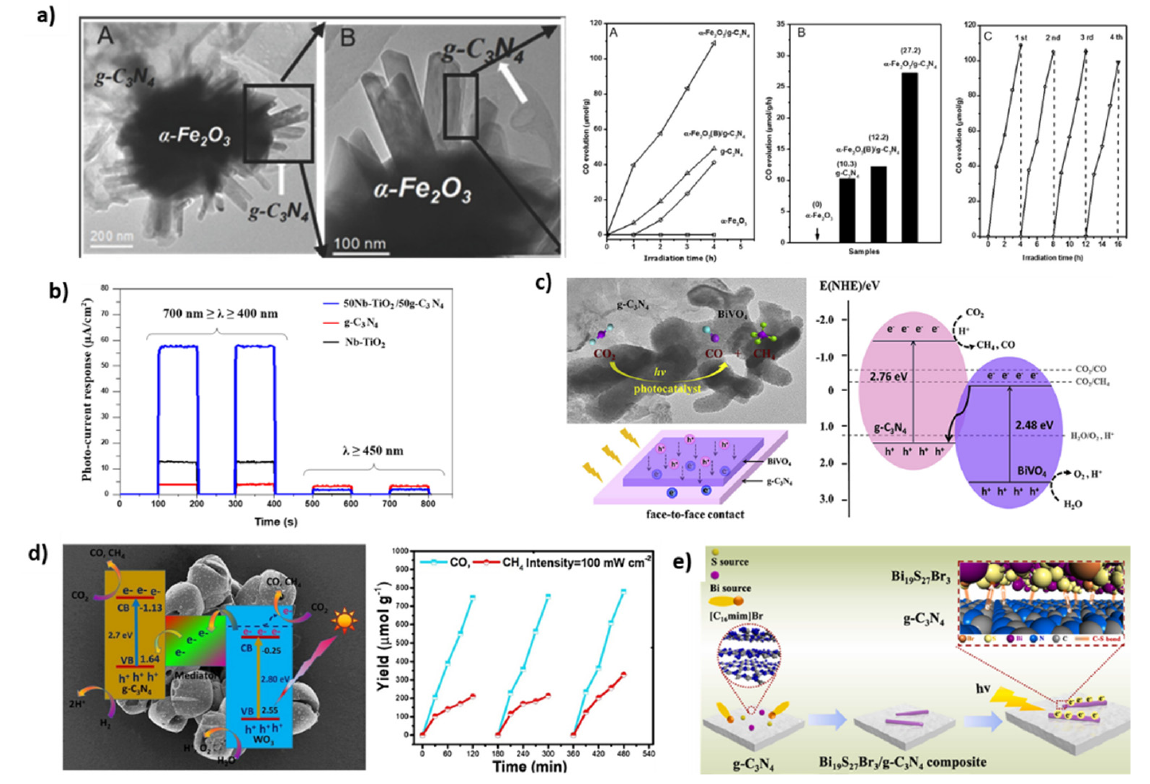
Figure 11. ( a ) TEM images of α -Fe 2 O 3 / g -C 3 N 4 (A) and high magnitude TEM images of α -Fe 2 O 3 / g - C 3 N 4 (B). Time courses of photocatalytic CO evolutions (A), average CO production rates of g -C 3 N 4 , α -Fe 2 O 3 (B), and α -Fe 2 O 3 / g -C 3 N 4 hybrid and recycling test of α -Fe 2 O 3 / g -C 3 N 4 (C). Reproduced from